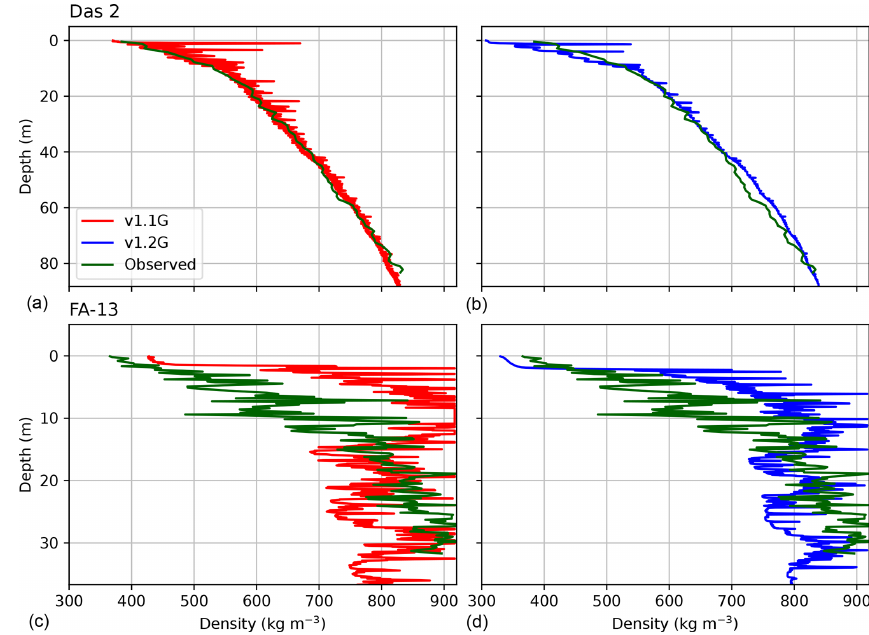
Figure 6. Density profiles for v1.2G (a, c) and v1.1G (b, d) model settings at Das 2 (a, b) and FA-13 (c, d) .